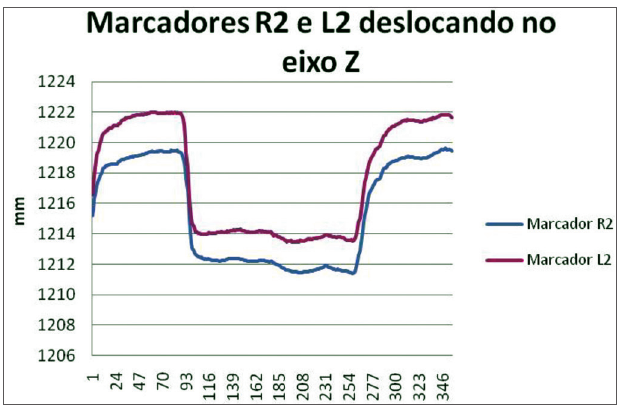
Figura 9. Marcadores R2 e L2 deslocando no eixo Z, fechando os olhos.